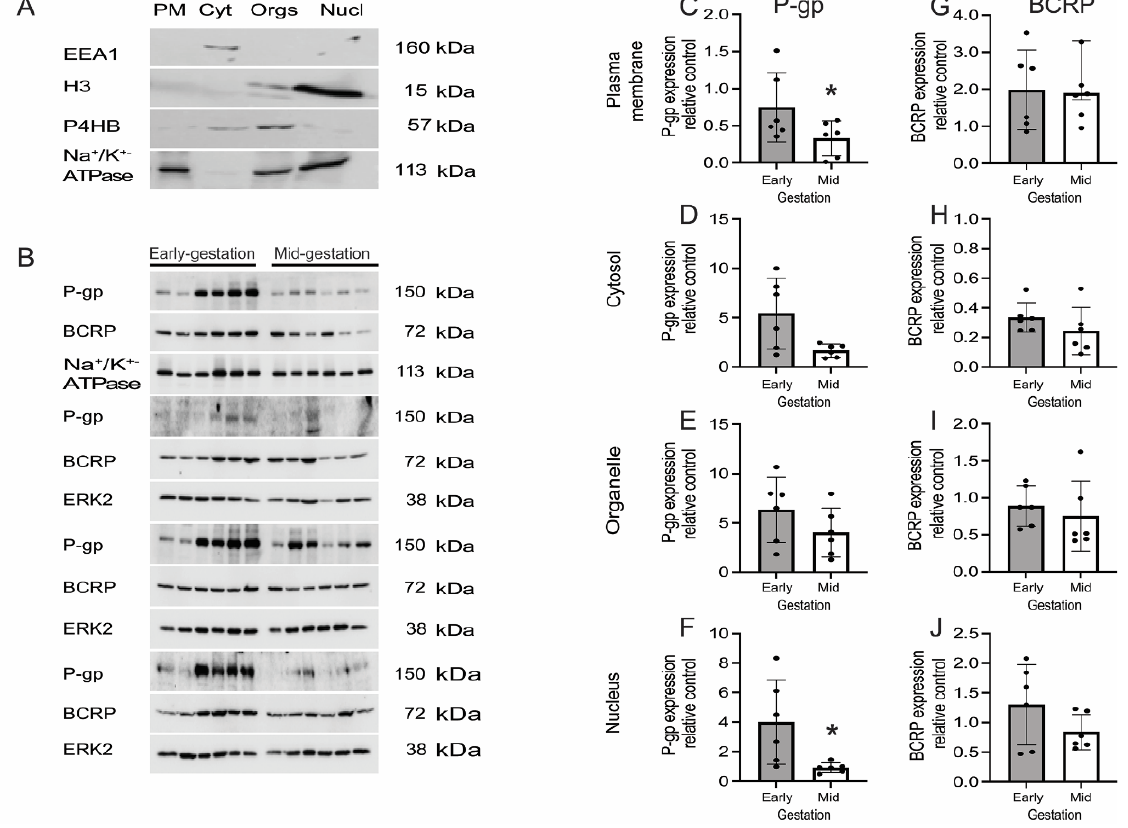
Figure 6. P-gp and BCRP distribution within subcellular fractions of early and mid-gestation hfBECs. ( A ) Representative western blot images showing specific markers in subcellular fractions of second trimester hfBECs: plasma membrane (PM, lane 1), cytosol (Cyt, lane 2), organelles (Orgs, lane 3), and nuclear (Nucl, lane 4) fractions. Sodium/potassium ATPase (Na + /K + -ATPase; plasma membrane marker), early endosome antigen 1 (EEA1; cytosol marker), prolyl 4-hydroxylase 3 (P4H3; endoplasmic reticulum (ER) marker) and histone3 (H3; nuclear marker), n = 3. ( B ) Representative western blot images and ( C – F ) densitometric analysis of plasma membrane, cytosolic, organelle (ER) and nuclear P-gp expression and ( G – J ) densitometric analysis of plasma membrane, cytosolic, organelle (ER) and nuclear BCRP expression, normalized to Na + /K + -ATPase (plasma membrane loading control) or ERK2 (loading control for cytosol, organelle and nucleus), in early and mid-gestation hfBECs. Data are expressed as mean ± SD. n = 6/group. Statistical differences were tested using an unpaired t -test. * p ≤